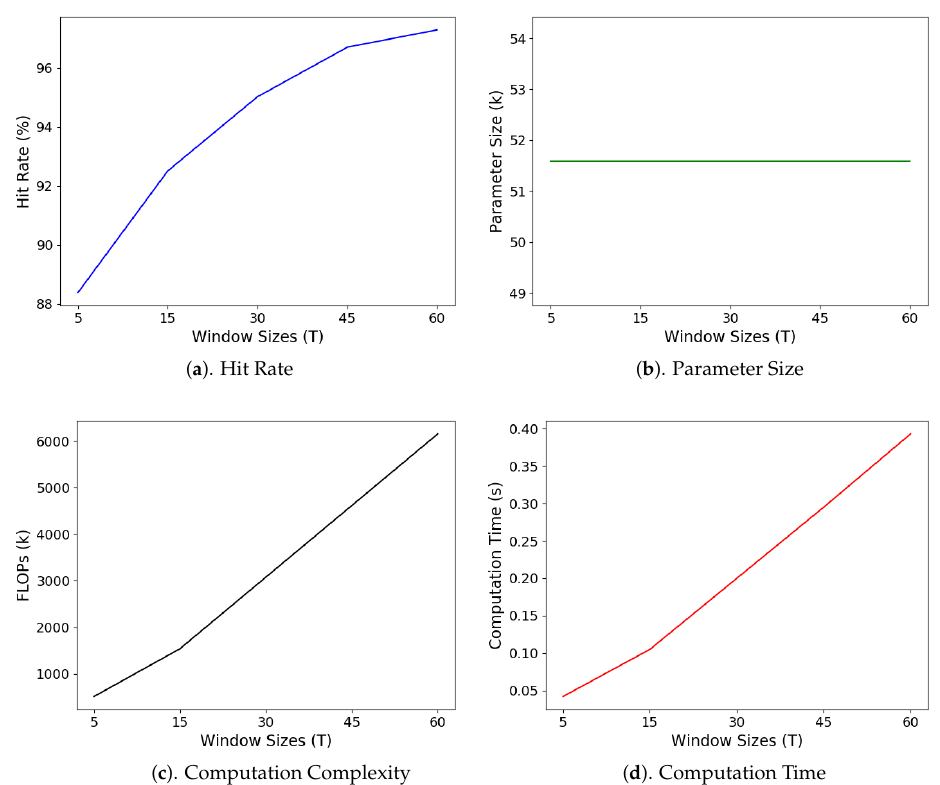
Figure 20. Average hit rate, parameter size, computation complexity, and average computation time of the GRU for different window sizes T . The average computation time is measured on the Raspberry Pi 3 platform. The dimension of the hidden states of the experiments was D =